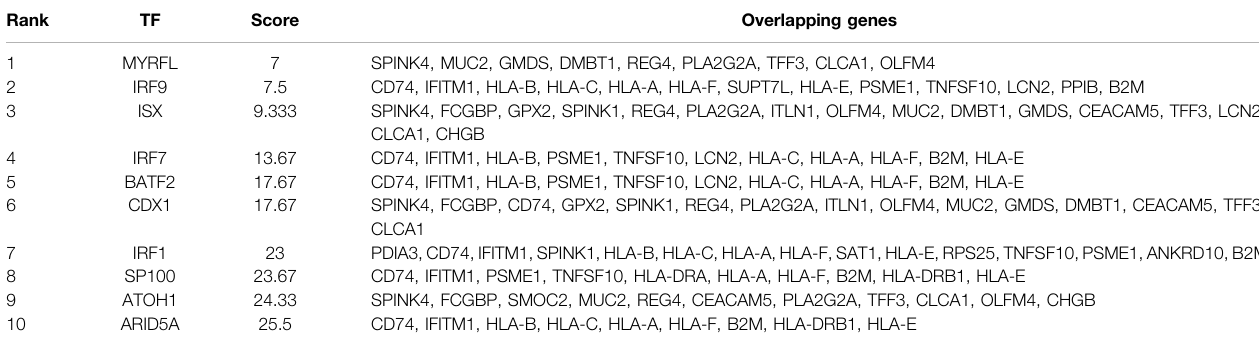
TABLE 2 | The results of transcriptive factor enrichment analysis from ChEA3, compared between EC-UC and EC-Con.